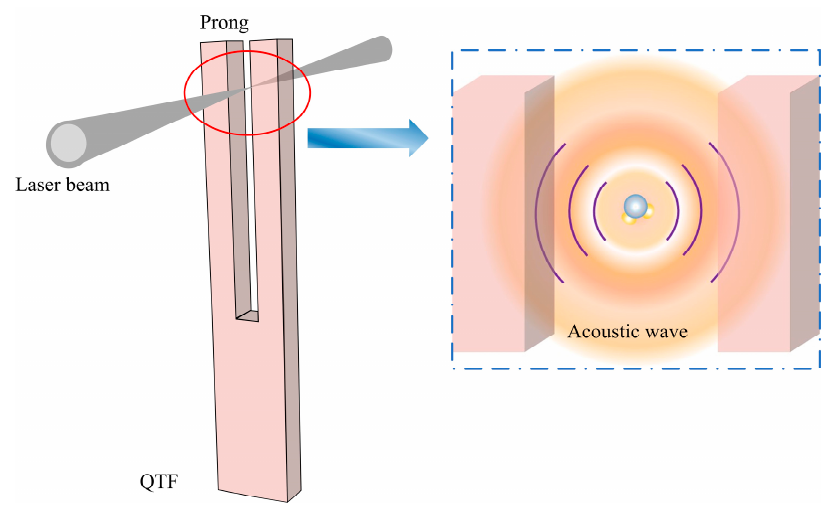
Figure 8. Schematic of the QTF, the laser beam, and the generated acoustic wave.